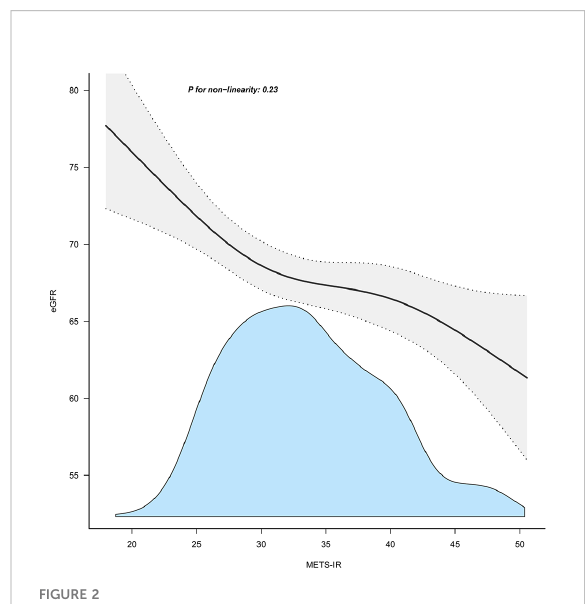
FIGURE 2 Association between METS-IR index and eGFR. METS-IR, metabolic score for insulin resistance; eGFR, estimated glomerular fi ltration rate.